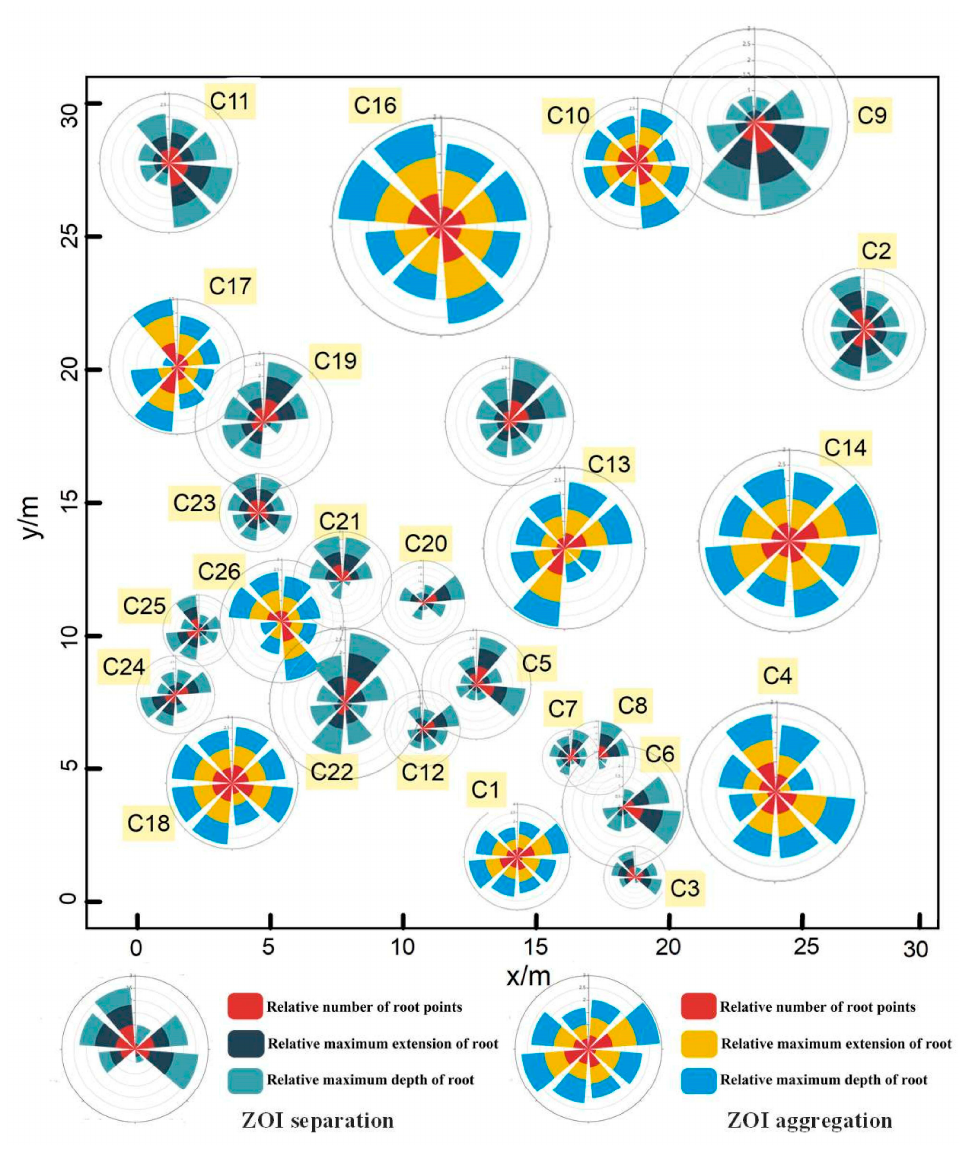
Figure 10. Rose diagrams derived from the ZOIs. The rose diagrams are divided into three layers, representing the relative number of root points, the relative maximum extension of roots, and the relative maximum depth of the roots in the ZOI in eight directions. Different color bars represent different ZOI types. The centers of the rose diagrams of the separated ZOIs are based on the canopy centers, while the centers of the rose diagrams of the aggregated ZOIs are based on the center of the ZOIs (since multiple plants share the same ZOI).